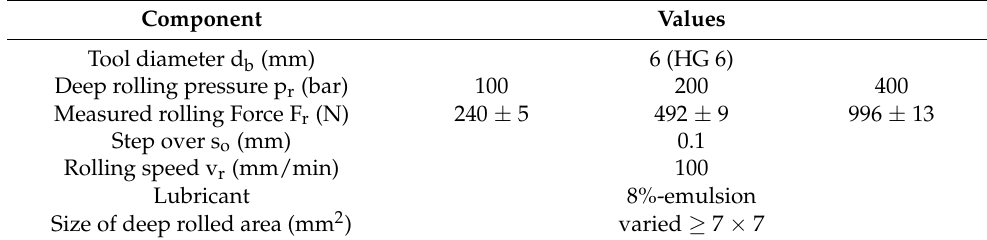
Table 3. Process parameter of the deep rolling process.